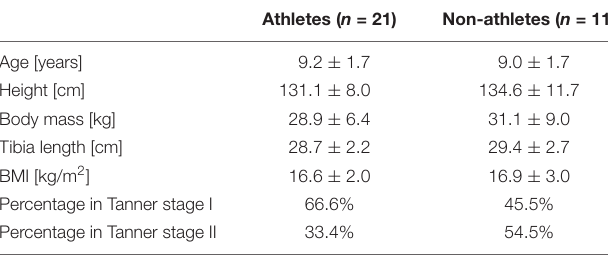
TABLE 3 | Anthropometric data and Tanner scale of the preadolescent athletes and non-athletes.